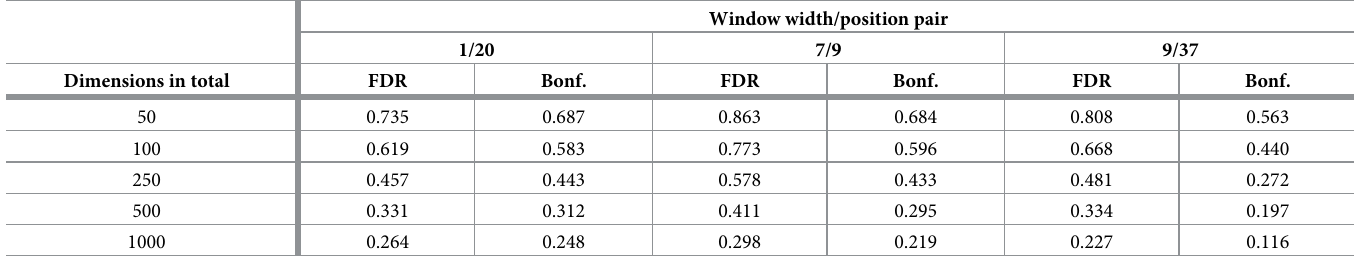
Table 1. Power of test for multinormality when the signal of the Introduction is augmented with a number of normally distributed